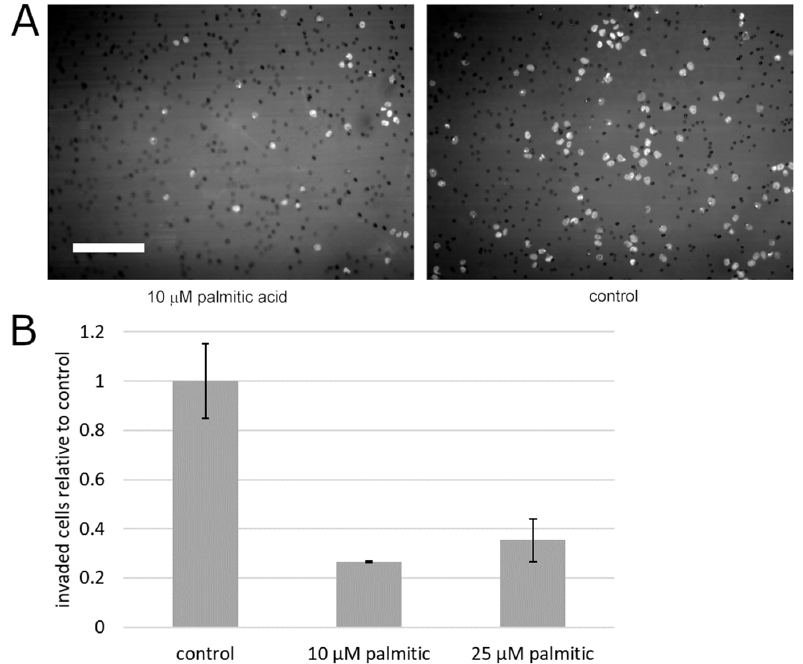
Figure 4. Palmitic acid significantly reduces extracellular matrix invasion by PC3 cells. ( A ) Representative microscopic images of 4 ′ -6-diamidino-2-phenylindole (DAPI)-stained PC3 cells on the bottom surface of the Matrigel-sealed transwell in the presence of 10 µM palmitic acid or the albumin carrier control. Bright spots are the cell nuclei and small dark circles are the pores in the transwell membrane. Scale bar: 200 µm. ( B ) Analysis of the number of invasive cells. Error bars, standard error on the mean. Each plotted value is the mean of 3 independent experiments. Nine microscopic fields covering the area of the transwell were acquired and quantified in each experiment, per treatment condition.